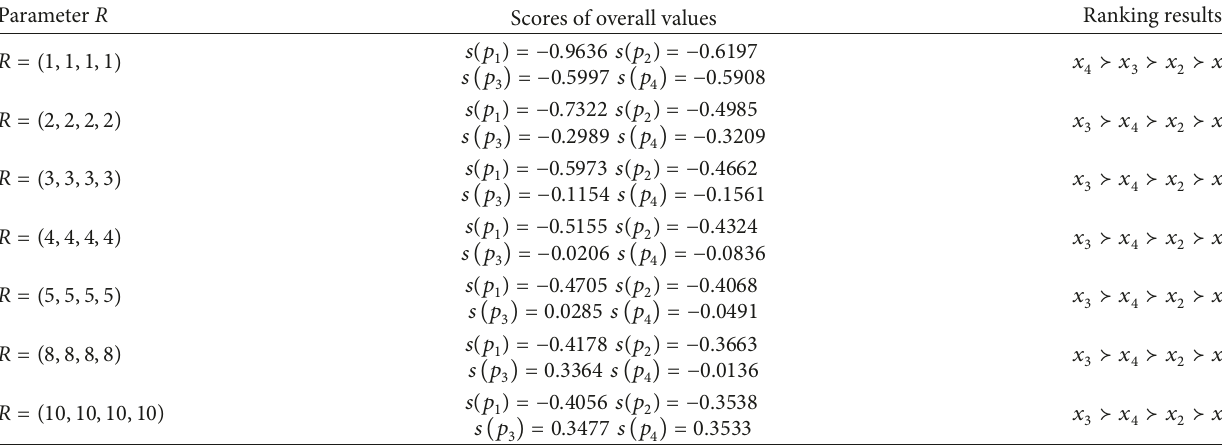
Table 4: Ranking results by assigning different values to parameter vector 𝑅 in the DGPFWBGM operator. Parameter R Scores of overall values Ranking